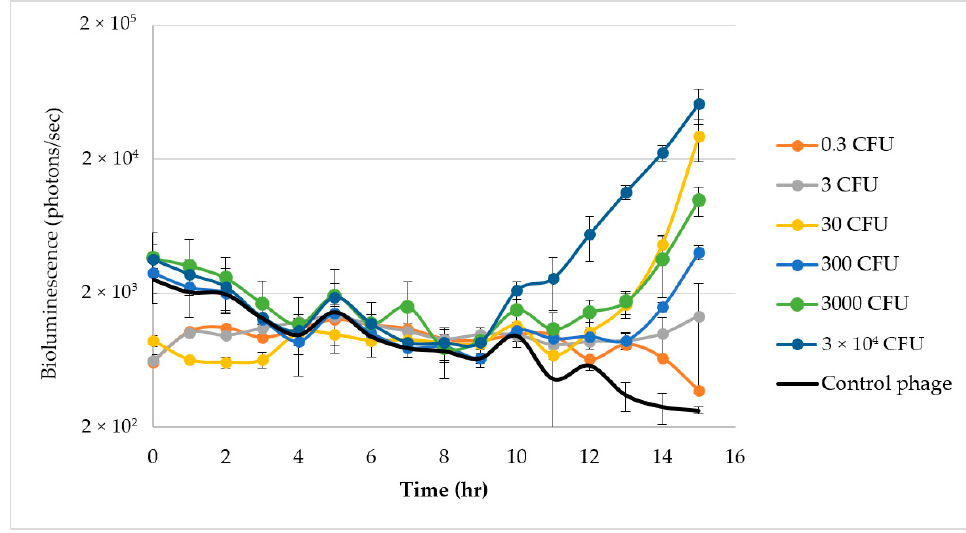
Figure 4. Time course of Luminescence detection of E. coli O157:H7 using the standard 1:3 ground beef to mTSB broth ratio in a stomacher bag enrichment format over time.